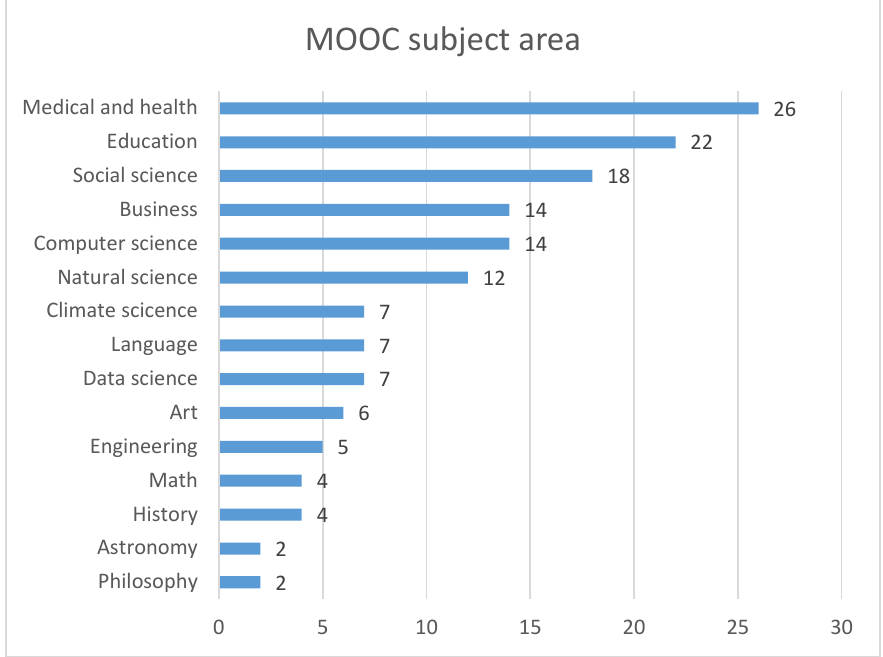
Figure 1. MOOC instructor departmental or primary discipline affiliations